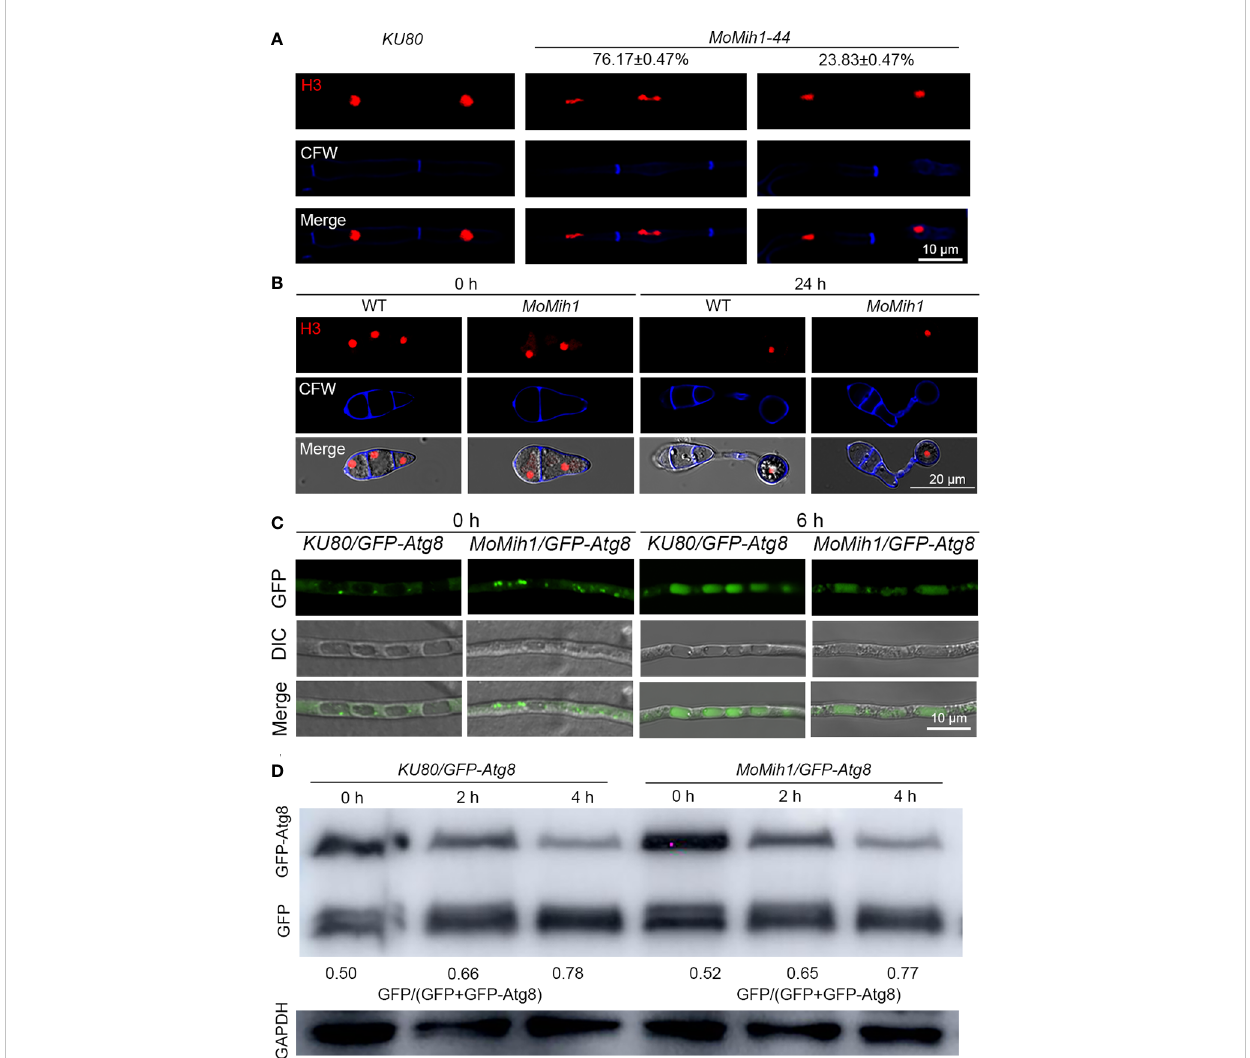
FIGURE 11 MoMih1 is required for nuclear division but not non-selective autophagy in M. oryzae. (A) Nuclear division in the hyphae of MoMih1 mutant. Hyphae of the KU80 and MoMih1 mutant that respectively expressed H3-RFP were stained with CFW and examined by CLSM. Bar = 10 m m. The proportion of each type of fungal cells was indicated in the fi gure. (B) Nuclear distribution during the appressorium development in MoMih1 mutant. Conidia of KU80 and MoMih1 mutant that respectively expressed H3-RFP were inoculated on hydrophobic coverslip for 0 or 24 h, stained with CFW, and examined by CLSM. Bar = 20 m m. (C) Localization of eGFP-MoAtg8 in the MoMih1-44 mutant. Both the parental strain KU80 and MoMih1-44 mutant were grown in liquid CM for 36 h, transferred to SD-N medium for 4 h and then examined by CLSM. Bar = 10 m m. (D) Immunoblot to detect the degradation of eGFP-MoAtg8. All tested strain were under the treatment of nitrogen starvation for 2 and 4 h, and then immunoblotted with anti-GFP antibody to analyze the breakdown of eGFP-MoAtg8 in the KU80 and MoMih1 mutant. The ratio of eGFP with eGFP+eGFP-MoAtg8 was